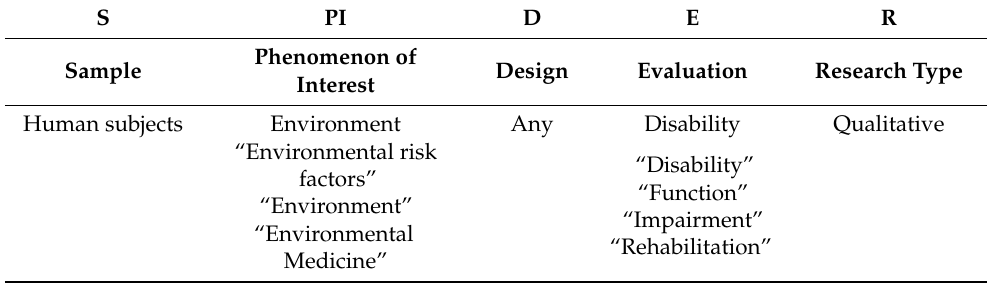
Table 1. Spider tool search